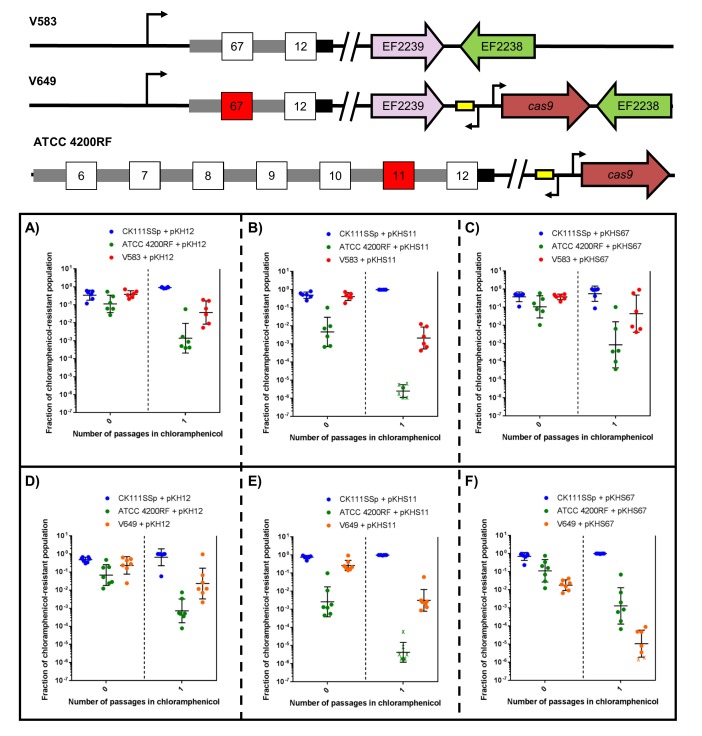
CRISPR defense alters population structure.The relative abundances of V583, V649, CK111SSp(pCF10-101), and ATCC 4200RF carrying a plasmid are plotted against the number of passages in chloramphenicol. Independent replicates are shown along with the geometric mean and geometric standard deviation. CK111SSp(pCF10-101), ATCC 4200RF, and V583 were propagated with (A) pKH12, (B) pKHS11 and (C) pKHS67. CK111SSp(pCF10-101), ATCC 4200RF, and V649 were also propagated with (D) pKH12, (E) pKHS11 and (F) pKHS67. The fraction of chloramphenicol resistant population was determined by strain-specific camR CFU/total camR CFU. ‘X’ indicate values that fell below the threshold of detection. Strain genotypes are shown for clarity.